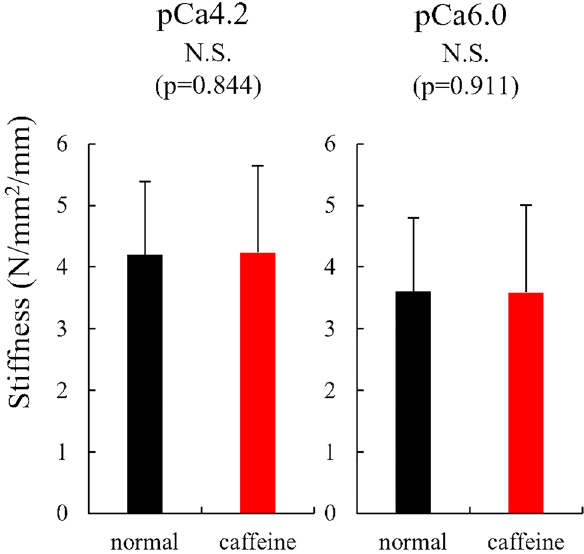
Figure 7. Stiffness obtained during the isometric phase for experiment 2 between normal and caffeine conditions (N = 9) (values are means ± SD).